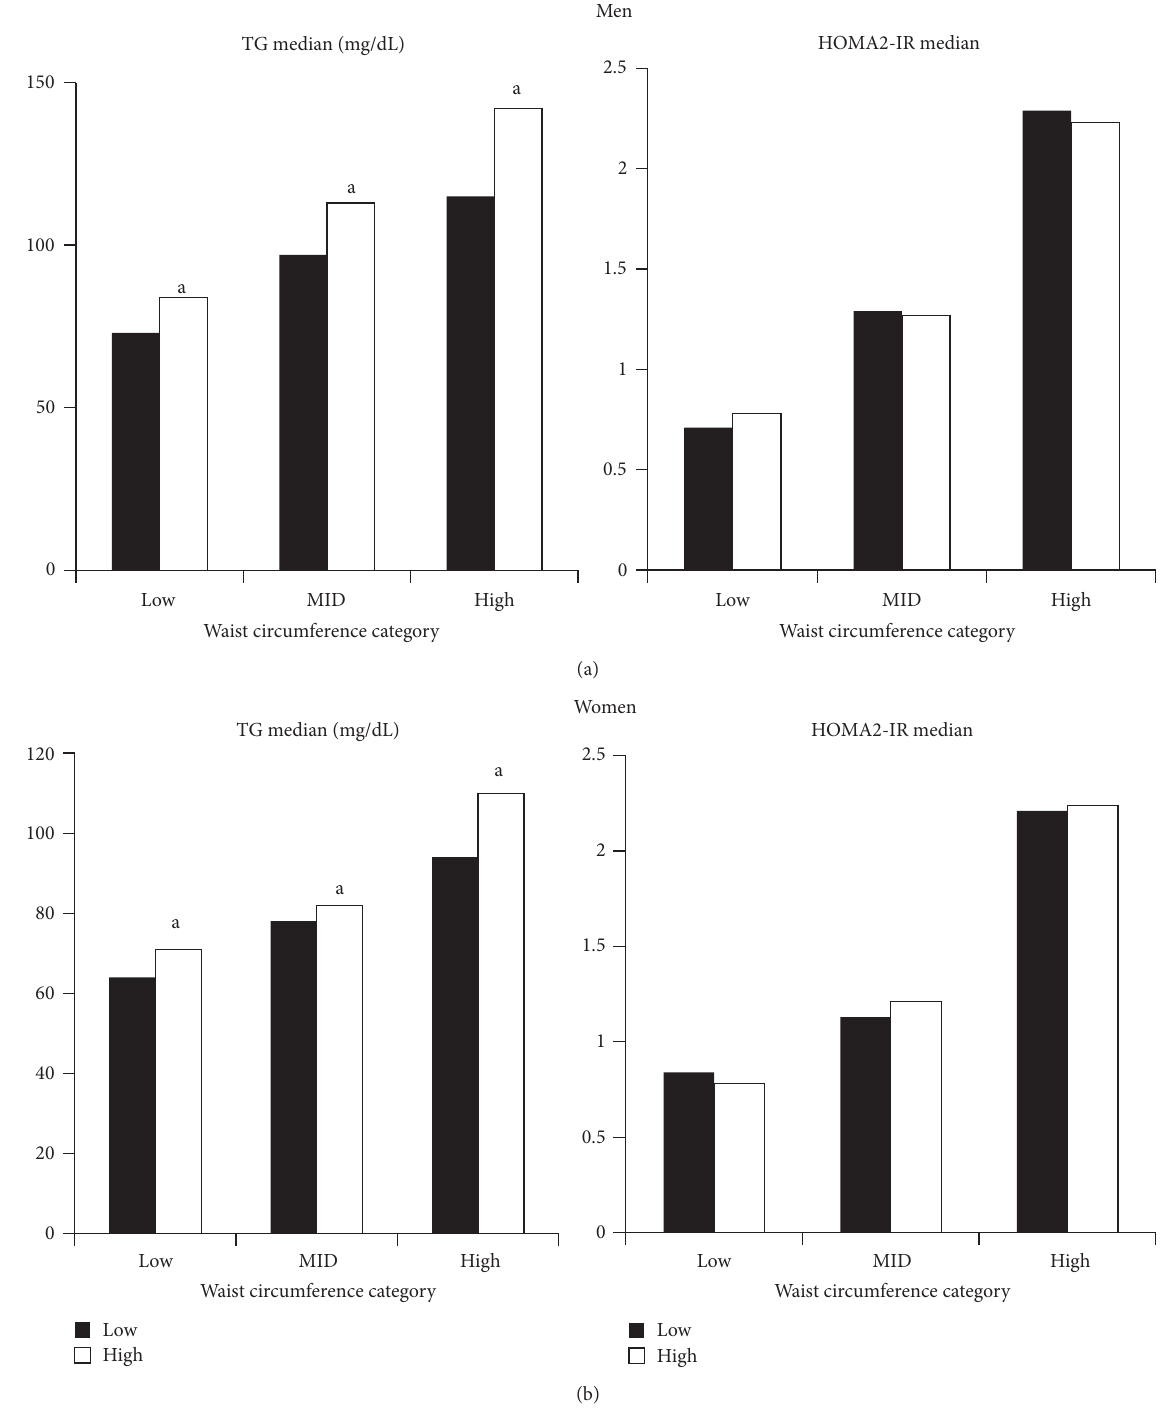
Figure 5: (a) Plasma triglyceride (TG) and HOMA2-IR for upper and lower halves of the intraperitoneal fat/abdominal subcutaneous fat ratios for all men. For TG, those with the high ratios had significantly higher triglyceride in each waist circumference category ( a 𝑃 < 0.05 ). For HOMA2-IR, there were no differences between higher and lower ratios. (b) Plasma triglyceride (TG) and HOMA2-IR for upper and lower halves of the intraperitoneal fat/abdominal subcutaneous fat ratios for all women. For TG, those with the high ratios had significantly higher triglyceride in each waist circumference category ( a 𝑃 < 0.05 ). For HOMA2-IR, there were no differences between higher and lower